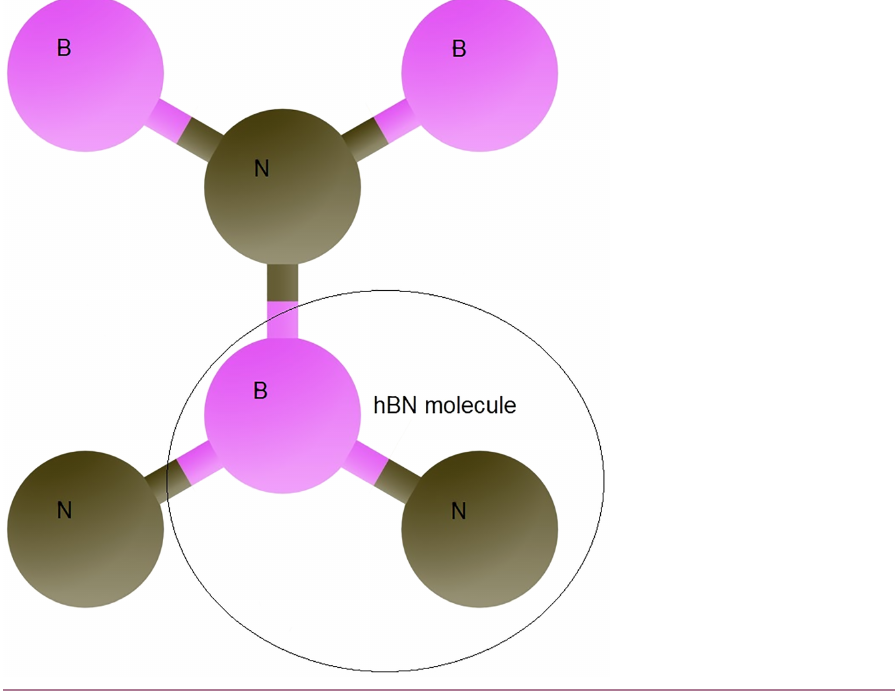
Figure 1 Illustration of an h-BN